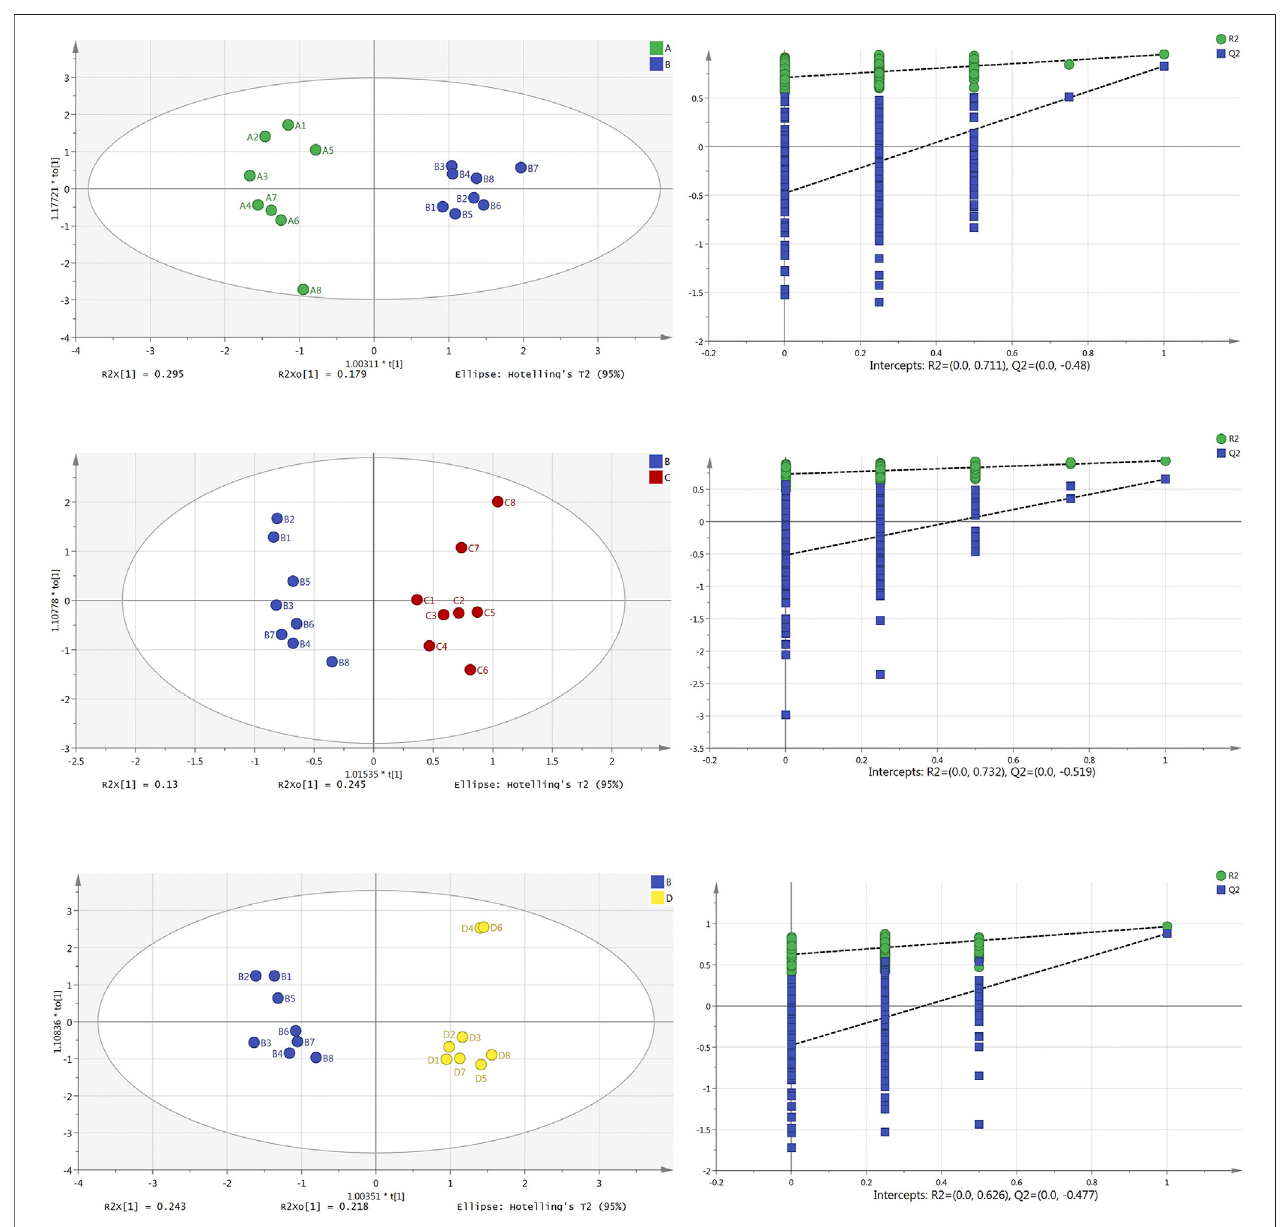
FIGURE 3 | OPLS-DA scores plot and permutation test diagram of normal group (A), model group (B), Borneol essential oil group (C), and reference group (D) in plasma samples ( n = 8).